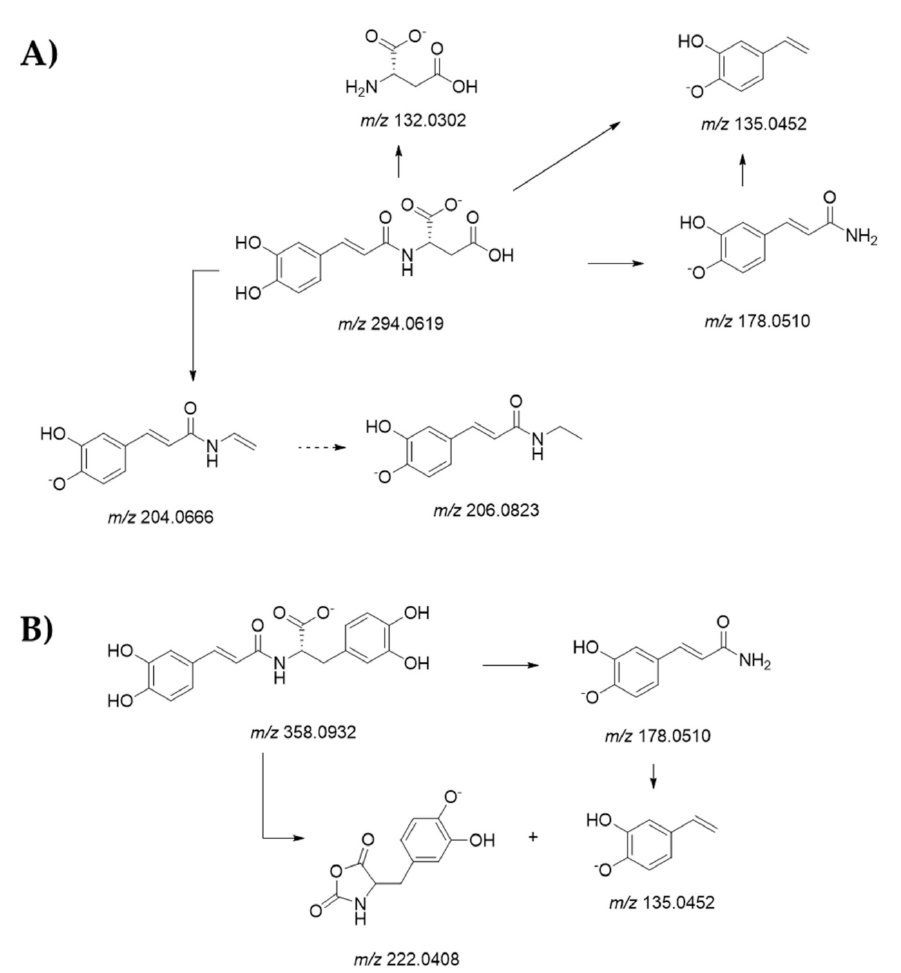
Figure 2. Fragmentation scheme of compounds. Proposed fragmentation scheme of compounds ( A ) 4 and ( B ) 10 . Theoretical m / z values are reported below each hypothesized